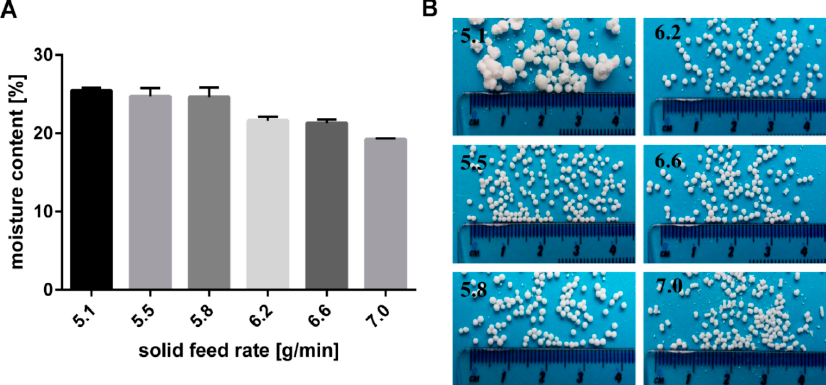
Figure 4. ( A ) Effect of solid feed rate (g/min) on moisture content of wet extrudates (NAM: MCC; 80%:20%) and ( B ) the resulting shape of spheronised particles. The granulating liquid was distilled water with a constant feed of 1.74